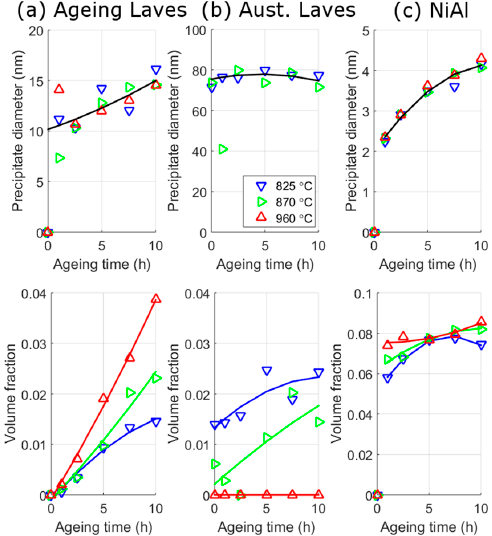
Figure 6. Results from SANS analysis of the change in size of precipitates ( top ) and the volume fraction of precipitates ( bottom ), with different ageing times at 540 °C after different austenitisation temperatures. Laves phase are separated based on whether they are formed during ageing ( a ) or austenitisation ( b ), and NiAl is ageing only ( c ).